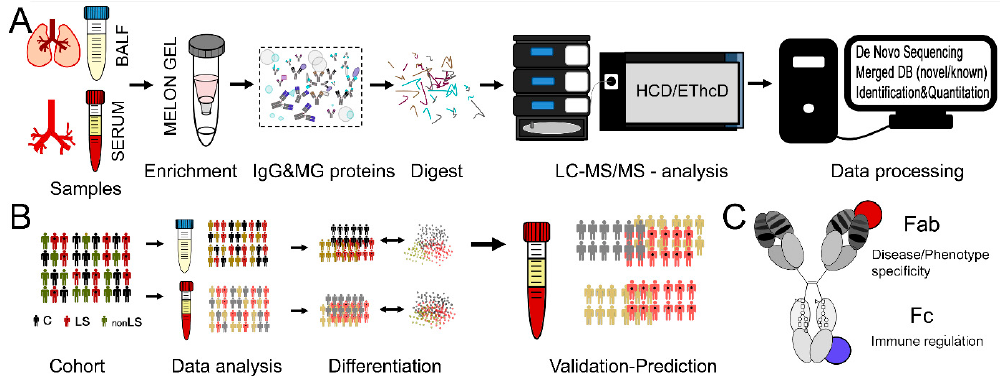
Figure 1. SpotLight approach and study design. ( A ) Samples from BALF and serum were IgG enriched, digested and subjected to LC-MS / MS analysis using HCD and EThcD fragmentation for de novo sequencing. New and known peptide sequences were merged into one database that was used for data identification and subsequent quantification. ( B ) Controls and sarcoidosis patients su ff ering from either nonLS or LS were selected. From each individual two intra-individually matched samples were obtained, one from lung (BALF) and one from blood (serum). Both sample types were subjected to di ff erential multivariate data analysis. The results from BALF were then used to predict / di ff erentiate the serum profiles that were treated as unknowns. ( C ) Di ff erent features measured via SpotLight proteomics. Fab sequence variation, potential Fab binding proteins and peptides, Fc-region variation, Fc-glycosylation pattern as well as immune regulatory Fc-binding proteins.